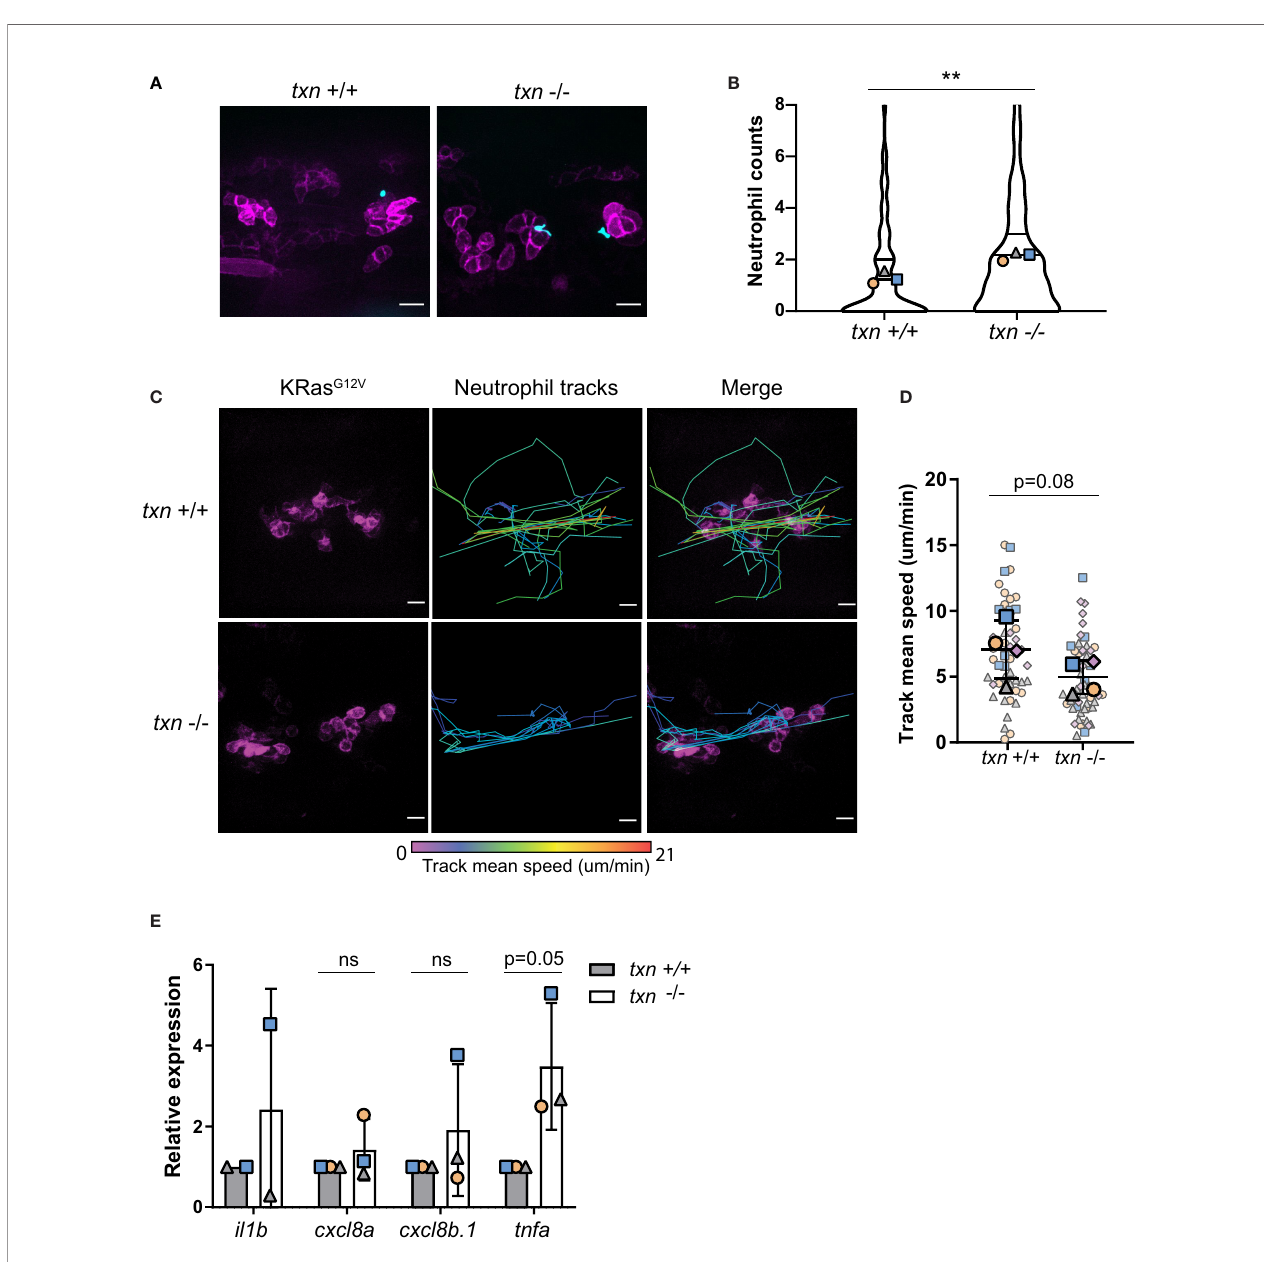
FIGURE 6 | Thioredoxin affects neutrophil motility around KRas G12V -transformed keratinocytes. (A) Neutrophil (blue) recruitment around KRas G12V -expressing basal keratinocytes (magenta) in txn +/+ Tg( LyzC : H2B-mcherry ) or txn -/- Tg( LyzC : H2B-mcherry ) larvae 3dpf. (B) Quanti fi cation of neutrophil abundance in txn wt (n=74) and mutant (n=116) larvae. (C) Stills from live imaging of neutrophil behavior around KRas G12V -expressing cells in txn wt and mutant larvae. Neutrophils were tracked across frames (1.5min/frame) and track color delineates instantaneous neutrophil velocity. (D) Quanti fi cation of average neutrophil speed in txn wt (n=4) and mutant (n=4) larvae. (E) TRAP-qPCR of KRas G12V -expressing genes assessing in fl ammatory cytokines il1b , cxcl8a , cxcl8b.1 , tnfa (pool, 30 larvae/replicate, wt n=3, mut n=3). Scale bar, 10uM. Bolded shapes indicate average values per larvae, and small shapes represent instantaneous velocities of individual neutrophils. Samples were analyzed for statistical signi fi cance via Mann-Whitney U test (B) and t-test (D, E) (p < 0.01**). ns, not signi fi